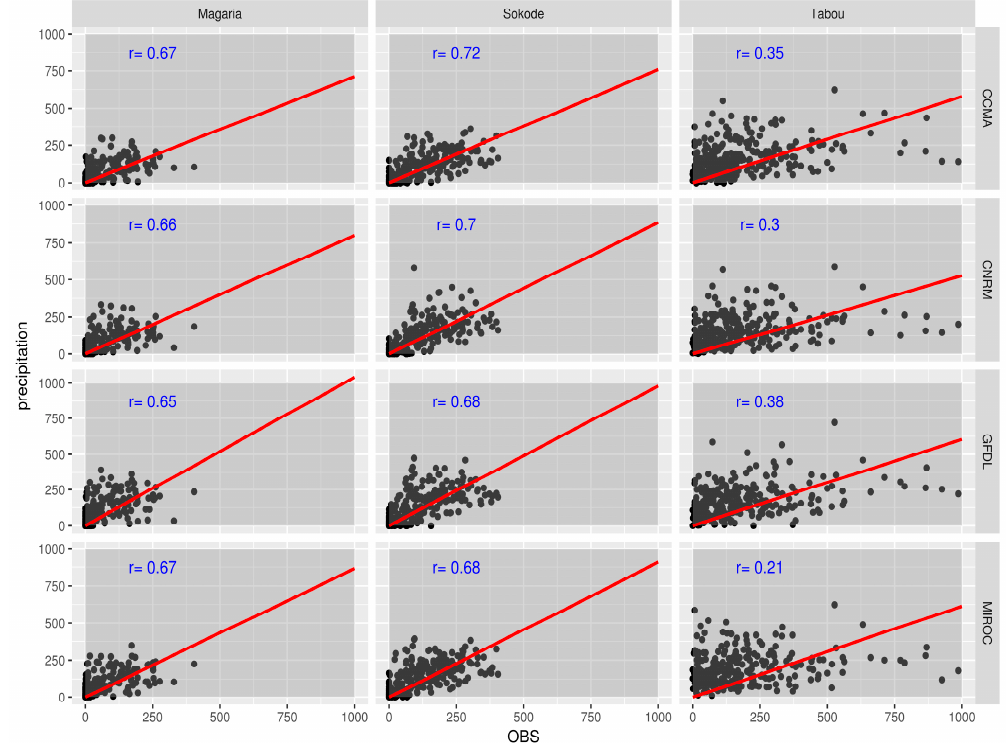
Figure 4. Total monthly rainfall (mm / month) as depicted by station observations and statistically downscaled CMIP5 GCMs (CCMA, CNRM5, GFDL, and MIROC) across the three agro ecological zones, Tabou, Sokode, and Magaria, of West Africa for the period 1980–2000. The top right corner r-values in each panel represent the correlations between the simulated and observed mean monthly temperature.